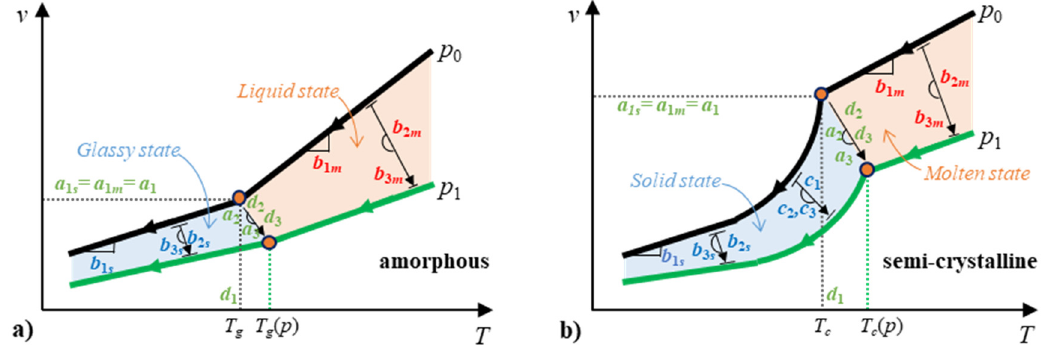
Figure 1. Schematic of the pressure-specific volume–temperature (pvT) curves for amorphous ( a ) and semi-crystalline ( b ) polymers and the relative parameters for the continuous two-domain equation of state (EoS).